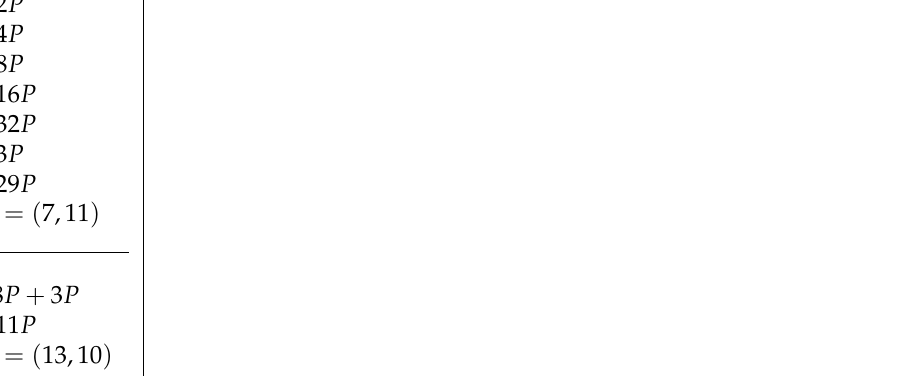
Figure 3. Computing the point 29 P by using remi_func and remi_point functions.